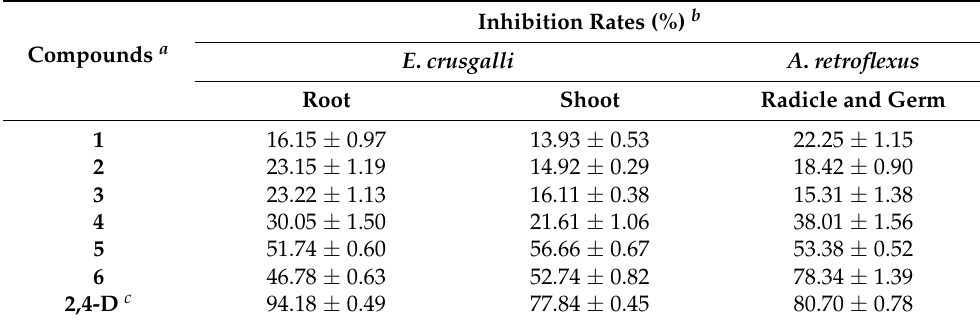
Table 4. Inhibitory effects of compounds 1 − 6 on the growth of the seedlings of E . crusgalli and A . retroflexus